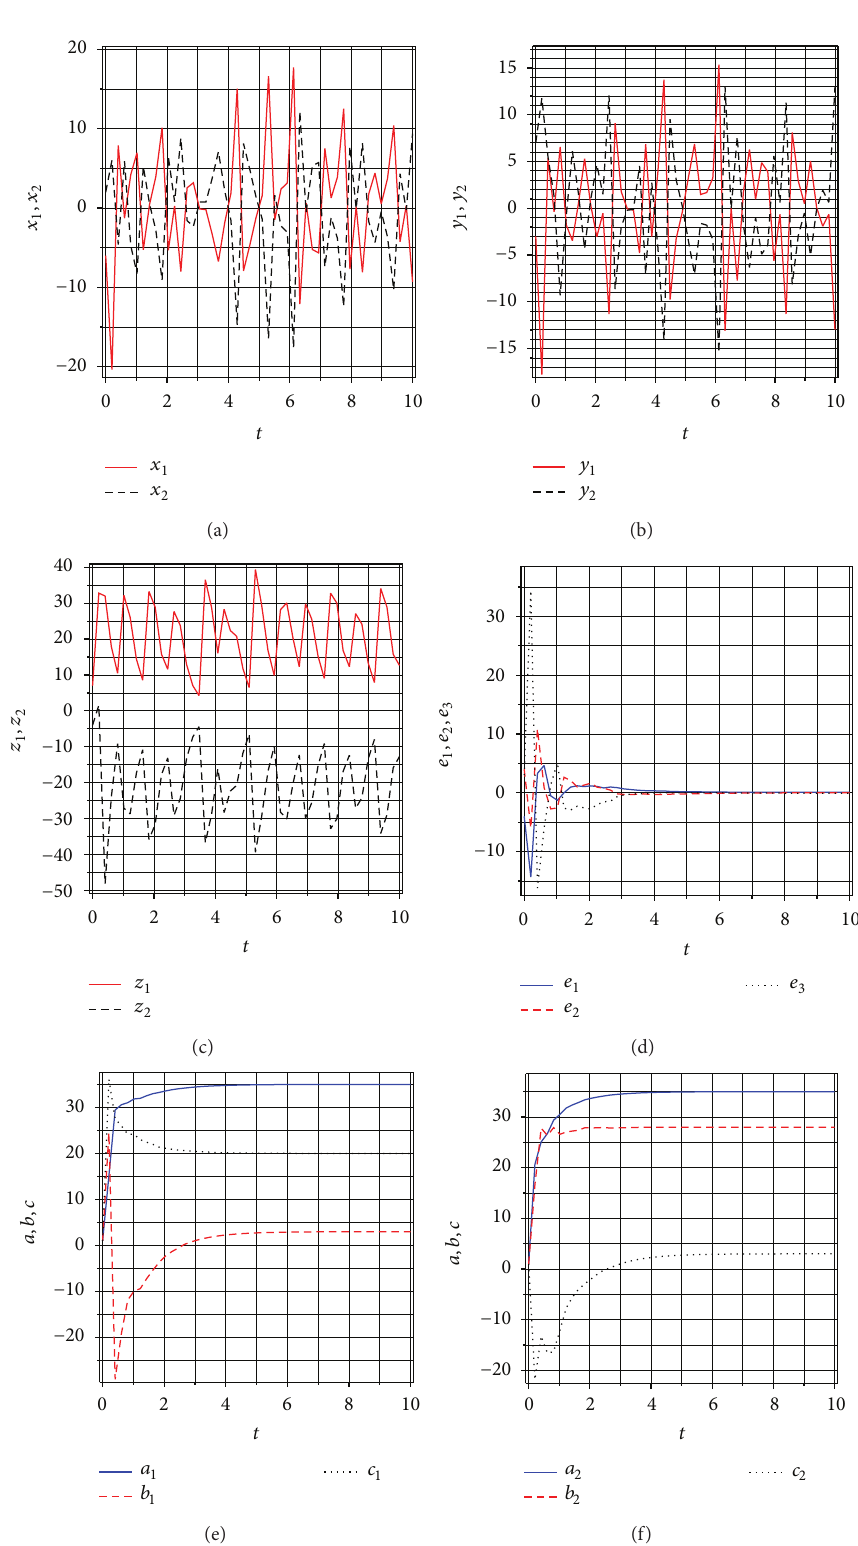
Figure 6: State trajectories of drive system (33) and response system (34): (a) signals 𝑥 1 and 𝑥 2 ; (b) signals 𝑦 1 and 𝑦 2 ; (c) signals 𝑧 1 and 𝑧 2 ; (d) the error signals 𝑒 1 , 𝑒 2 , 𝑒 3 of the hyperchaotic L¨u and Chen systems under the controller (37) and the parameters update law (38); (e)-(f) changing parameters 𝑎 1 , 𝑏 1 , 𝑟 1 and 𝑎 2 , 𝑏 2 , 𝑐 2 of the hyperchaotic L¨u and Chen systems with time 𝑡